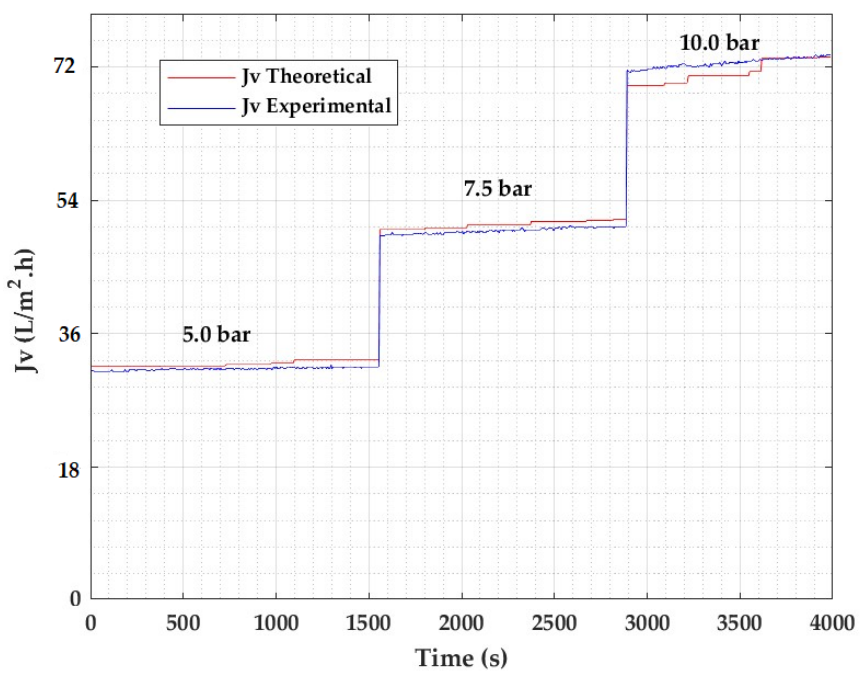
Figure 12. Theoretical vs. experimental flux of Pb: medium concentration.